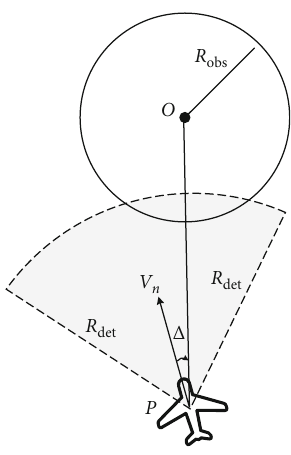
Figure 8: Obstacle detection and